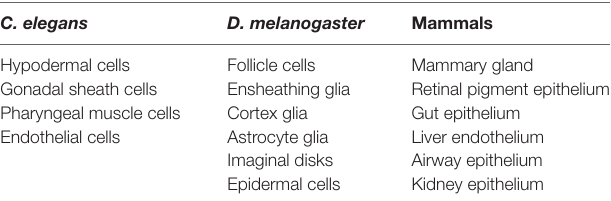
TAble 2 | Examples of non-professional phagocytes in C. elegans, D. melanogaster , and